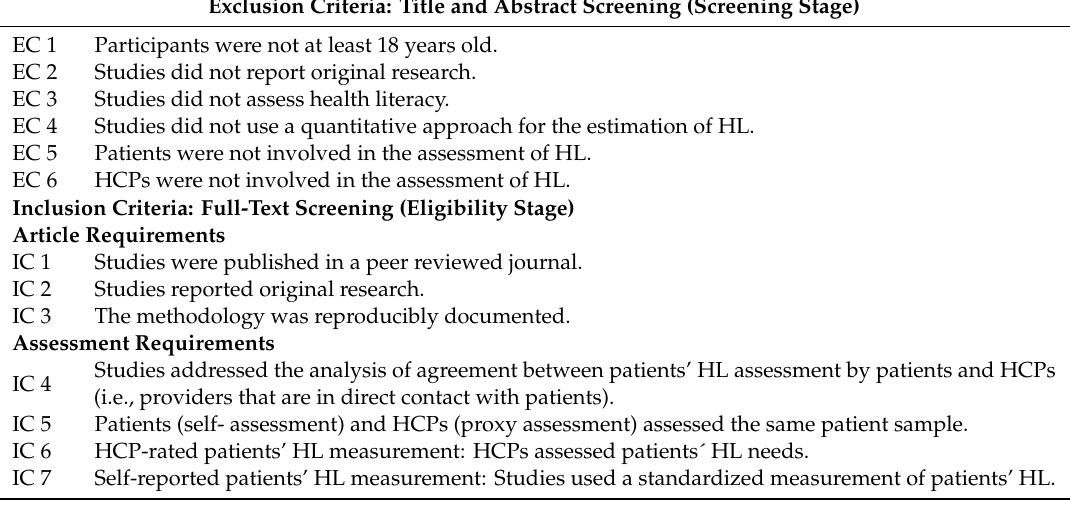
Table 1. Exclusion and inclusion